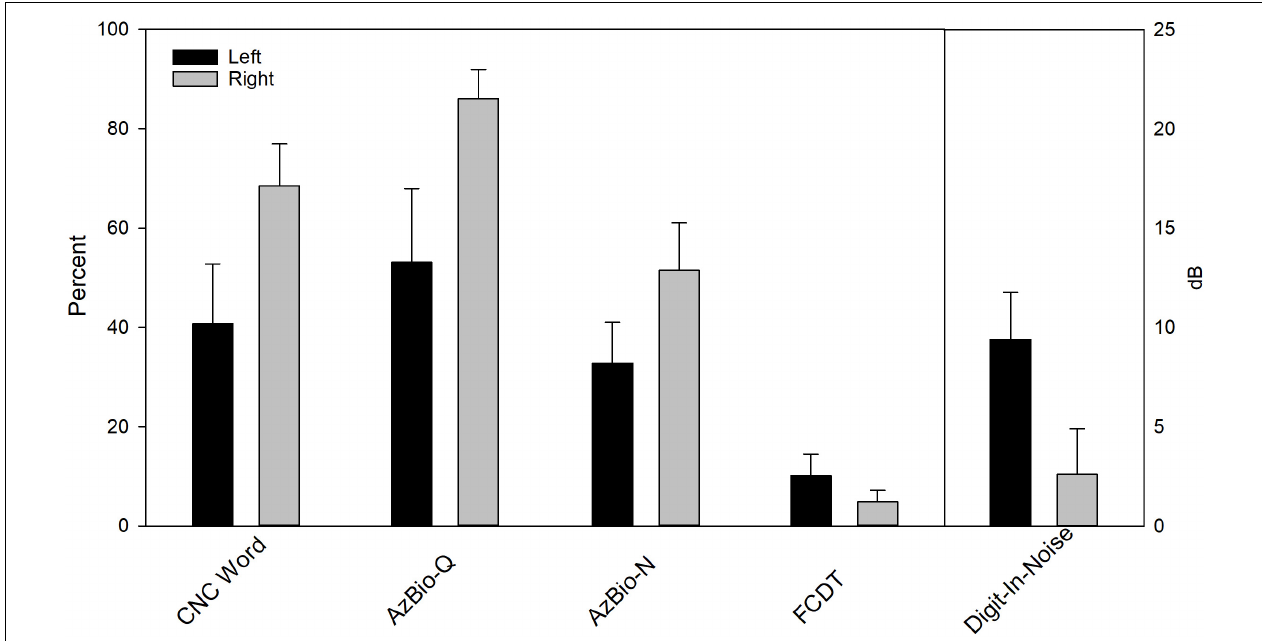
FIGURE 6 | The behavioral performance for Left (left) and Right CI ears (right) in eight bilateral CI users. Wilcoxon Signed Rank Tests showed Right CI ears had better CNC score than Left CI ears ( p < 0.05). After correcting for multiple pairs of comparisons, the difference did not reach statistical significance ( p >